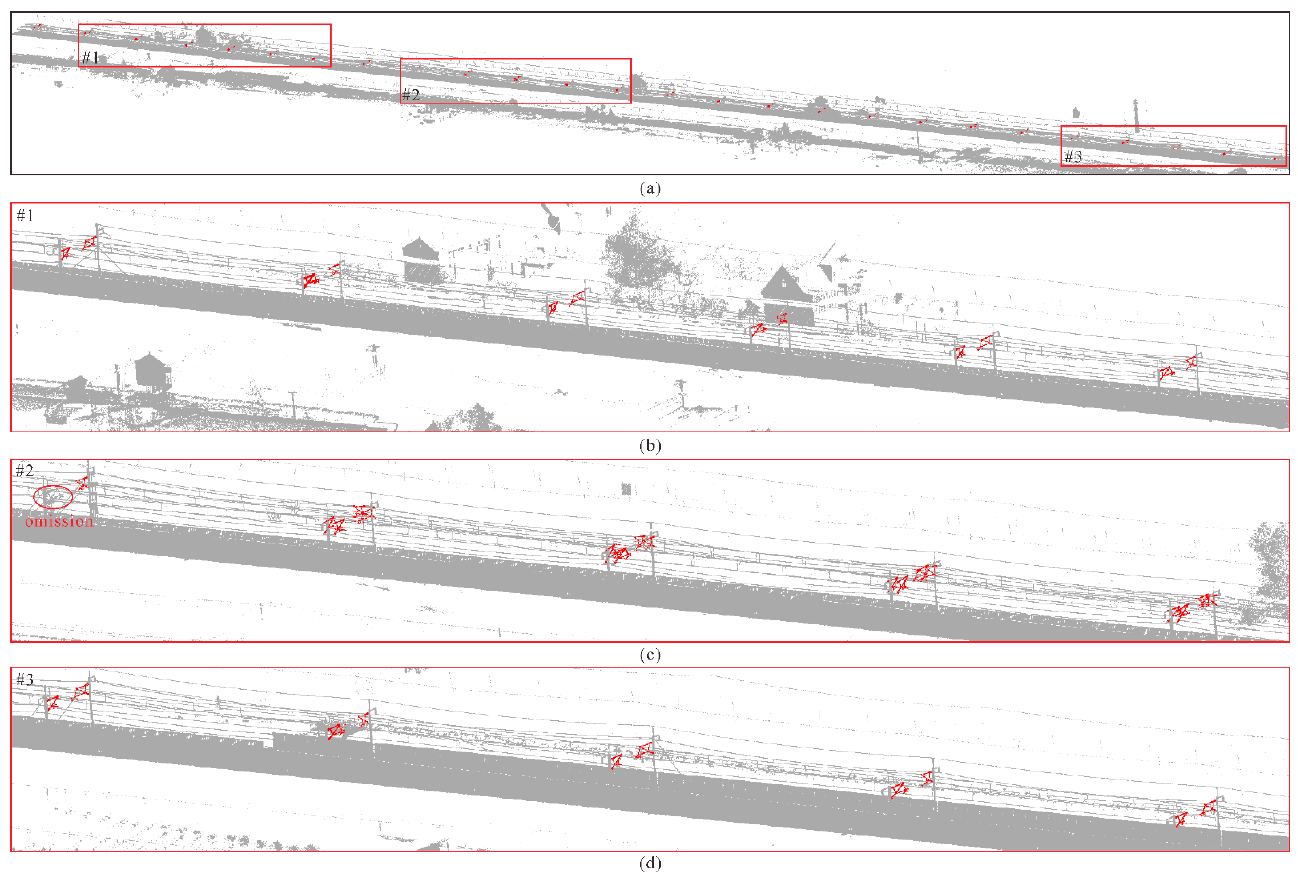
Figure 10. Applied experiment test results of unit 2. Specifically, ( a ) shows the test results, ( b ) shows close-up views of region #1, ( c ) shows close-up views of region #2, and ( d ) shows close-up views of region #3.